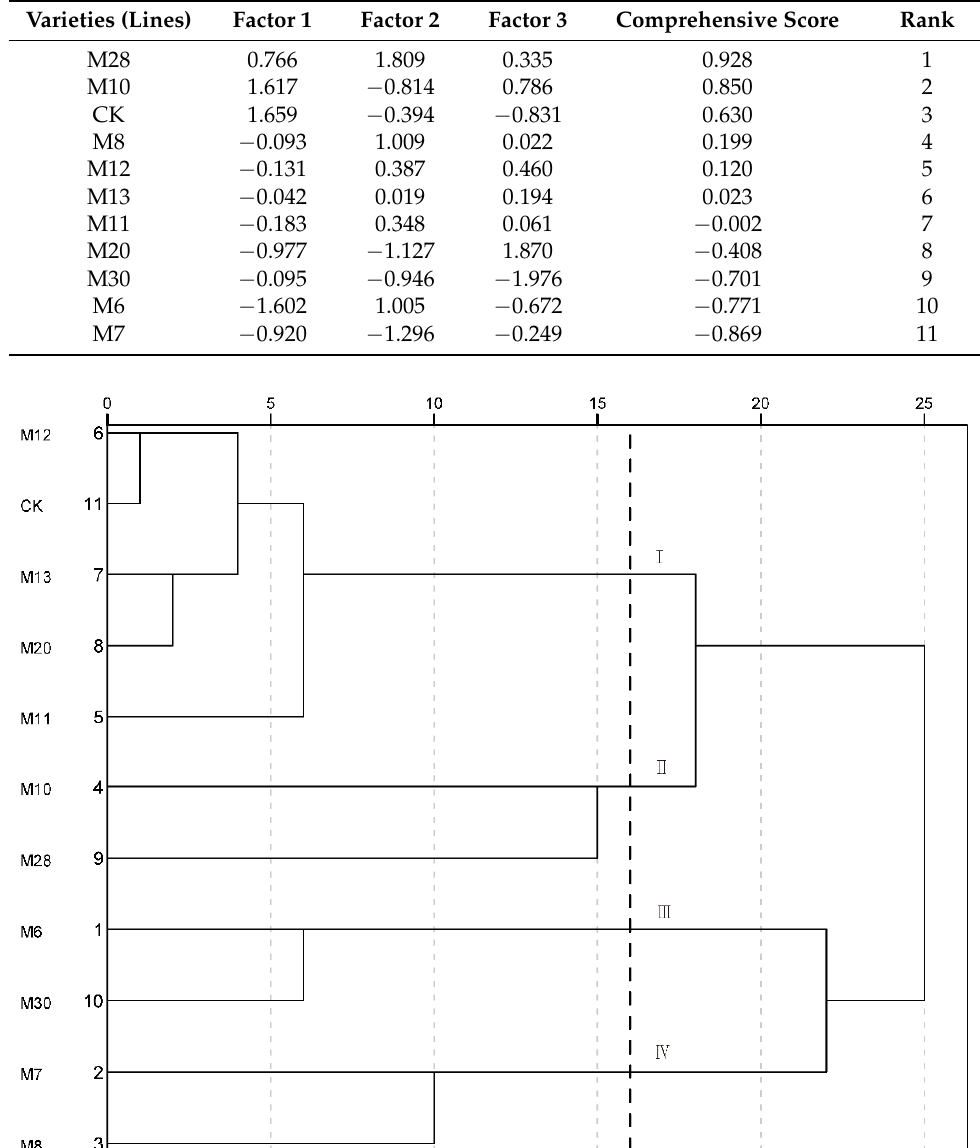
Table 4. The principal component scores, comprehensive scores and ranking of fruit quality for wild A. eriantha .